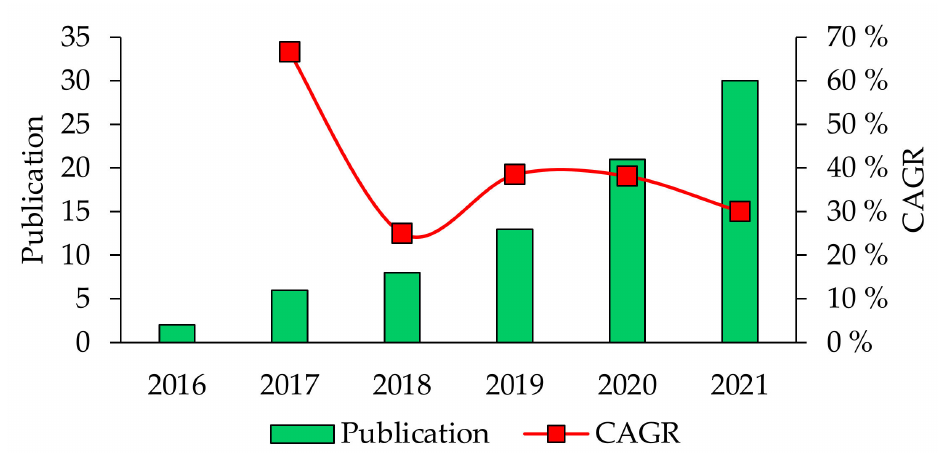
Figure 1. Historical evolution of research in UAVs for sugarcane.